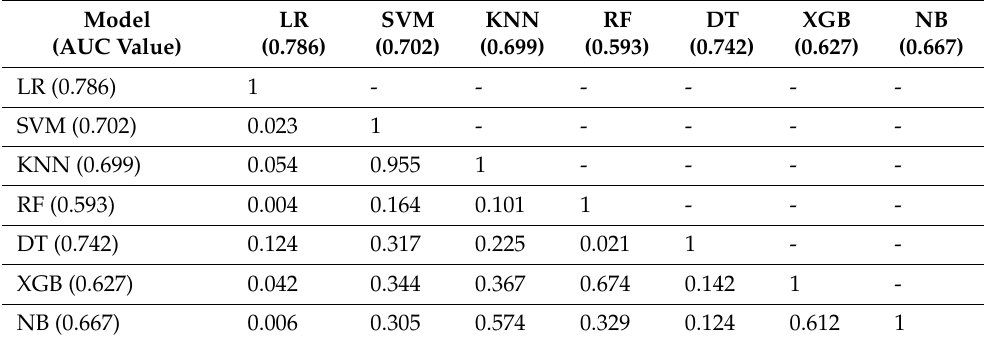
Table 5. P values for AUC comparison between any pair of models tested by the DeLong method in the validation set.